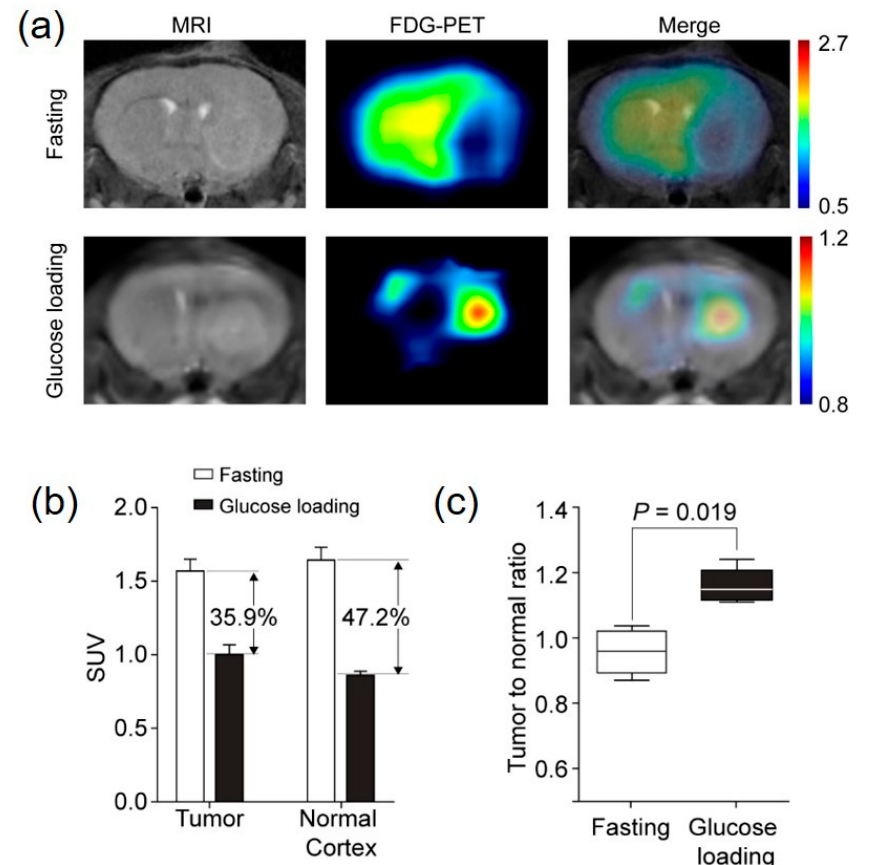
Figure 1. ( a ) 18 F ‐ FDG PET/MRI images of mice U87MG xenograft models after fasting and with glucose loading. ( b ) Maximum standardized uptake value (SUVmax) in the tumor and normal cortex after fasting and glucose loading. ( c ) Tumor to contralateral cortex ratio after fasting and